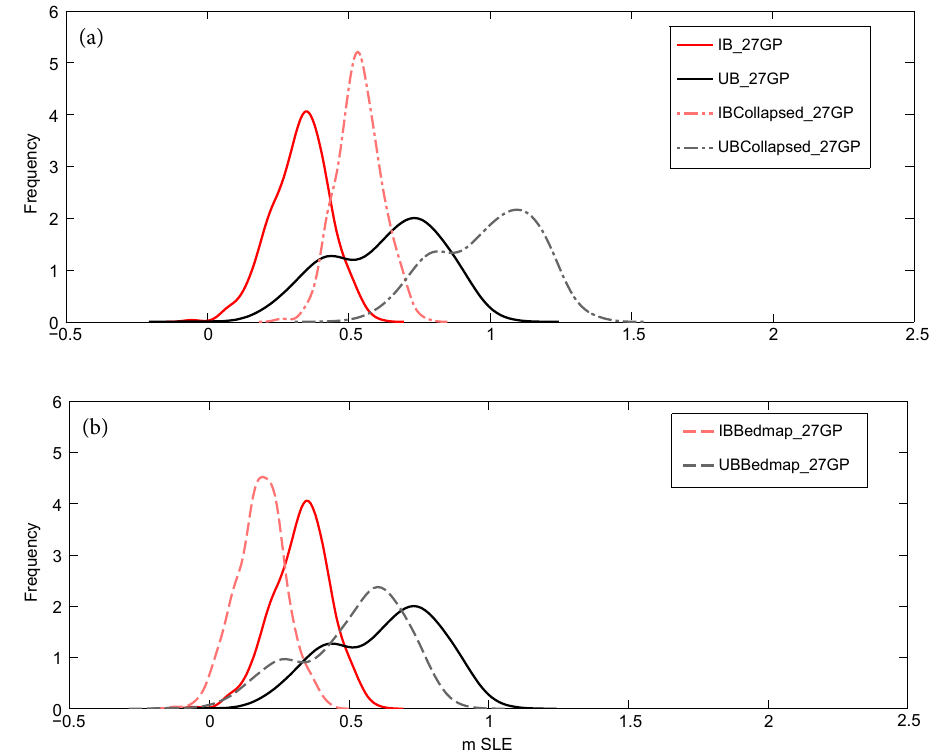
Figure 5. PDFs of SLE resulting from ensemble runs with 800 simulations using GP partitioning, comparing the effects of using different boundary forcing. (a) Curves resulting from sampling of UB (UB_27GP, black) and IB (IB_27GP, red) experiments, compared with results from runs forced with the collapse of all Antarctic ice shelves at the beginning of the simulation (dash-dot) (UBCollapsed_27GP and IBCollapsed_27GP). (b) Plot similar to (a) but with additional ensemble runs showing the impact of using a bedrock topography (dashed) derived from Bedmap1 (UBBedmap_27GP and IBBedmap_27GP). See Table 3 for statistics relating to each